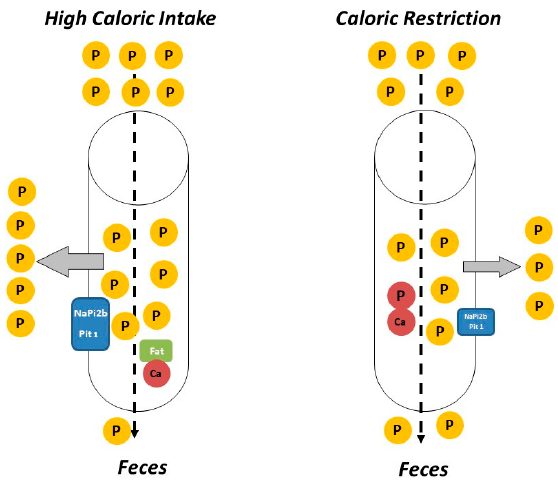
Figure 1. Caloric intake (especially fat intake) influences phosphorus (P) balance. High caloric intake ( left ) usually is associated with consumption of foods with higher P content than calorie-restricted foods ( right ). In addition, intestinal absorption of P is generally more efficient in calorie-rich/fat-rich food due to the formation of fat–calcium (Ca) soaps and to upregulation of P transporters (NaPi2b and Pit1). Thus, calorie/fat restriction tends to decrease P balance and plasma P concentrations.